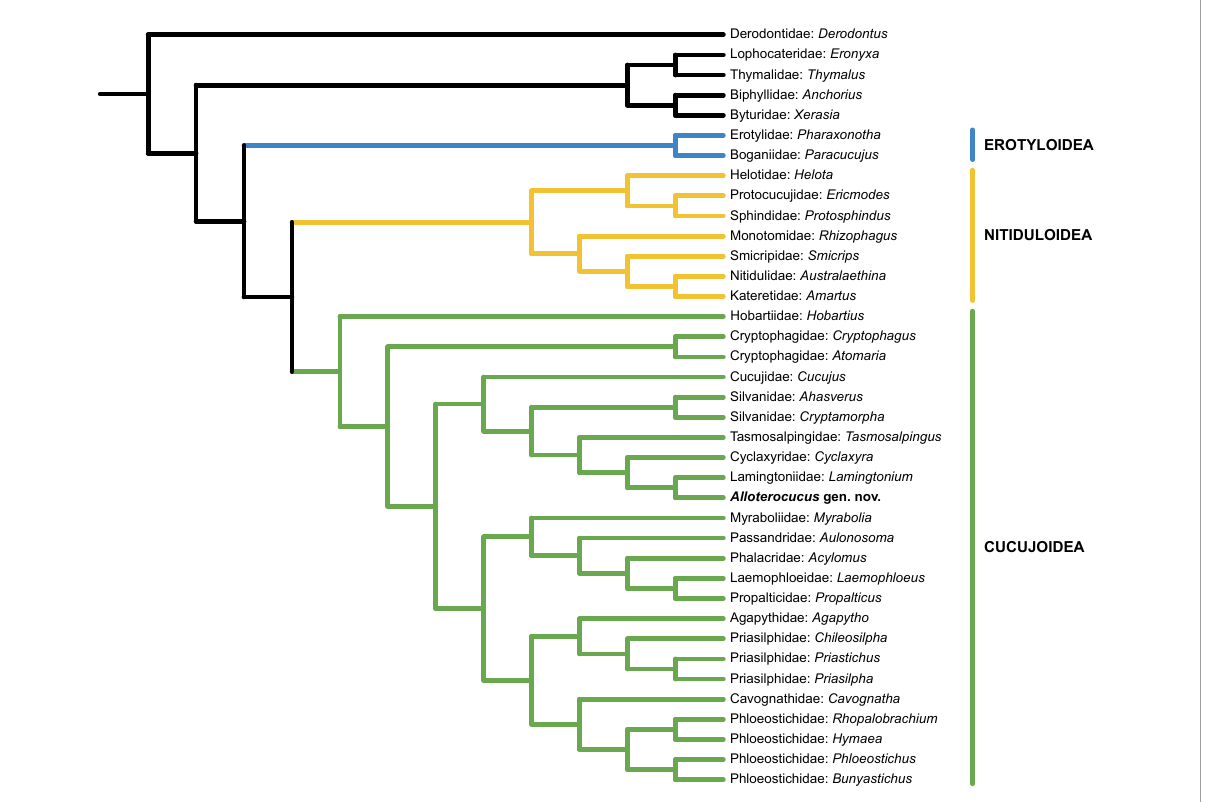
FIGURE4 Placement of Alloterocucus Li, Leschen Liu, and Cai gen. nov. based on the single tree resulting from the constrained parsimony analysis.